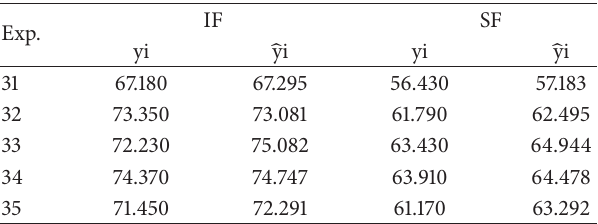
Table 11: Chemical composition of insoluble and soluble fibres concentrates (g/100g dry